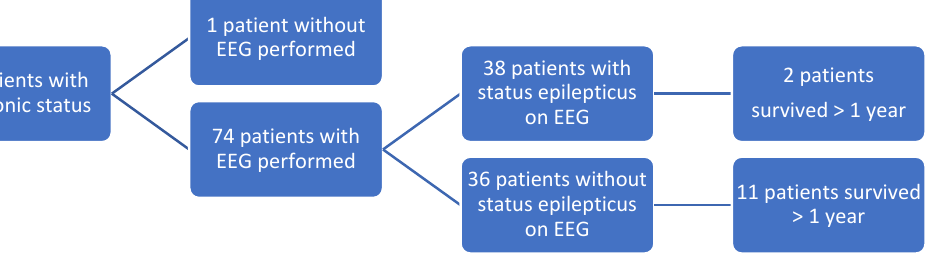
Figure 1. Flow chart showing the investigated patients. Of the 382 patients included in the study, 307 patients did not exhibit myoclonic status. Thus, the final study population consisted of 75 patients having myoclonic status following OHCA. Within this population, 92 EEGs were obtained in 74 patients. Thirty-eight of these patients with clinical myoclonic status had EEG-verified status epilepticus (see Figure 2).